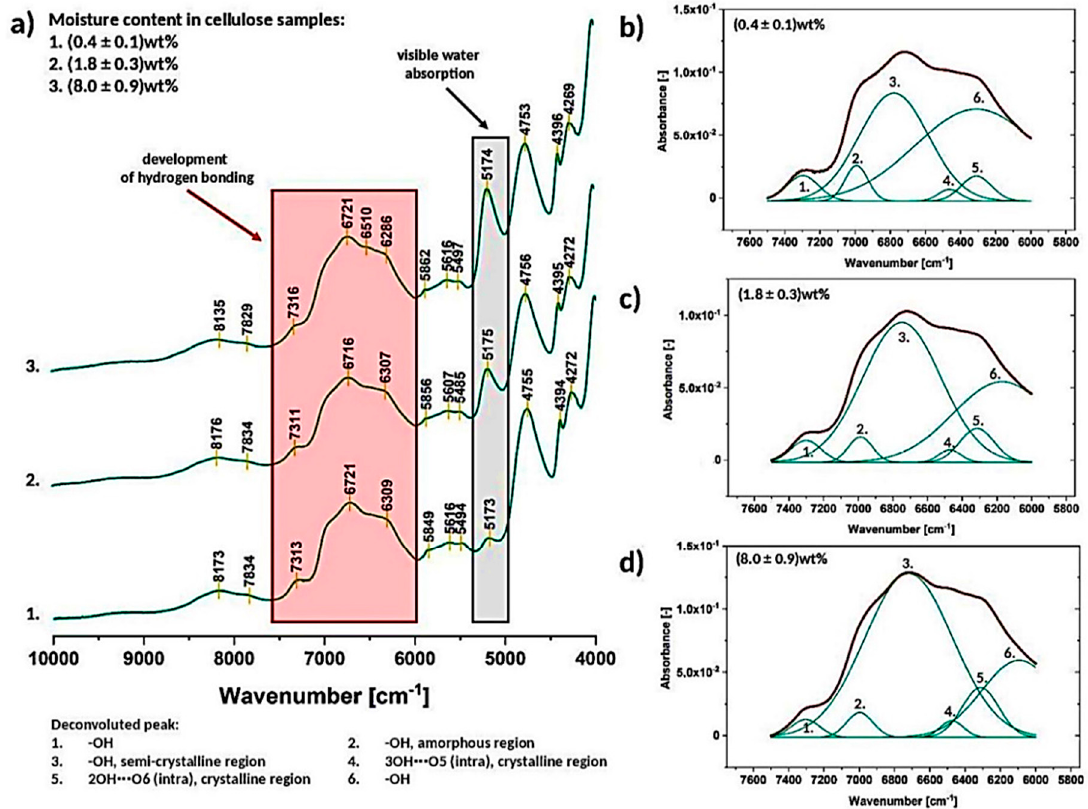
Figure 9. Exemplary near infrared spectra of cellulose of different moisture content ( a ) with deconvoluted absorption band between 7500–6000 cm − 1 for the cellulose moisture content of (0.4 ± 0.1) wt% ( b ), (1.8 ± 0.3) wt% ( c ) and (8.0 ± 0.9) wt% ( d ). Table 2. Tabularized values of wavenumber attributed to the chemical groups. Wavenumber [cm − 1